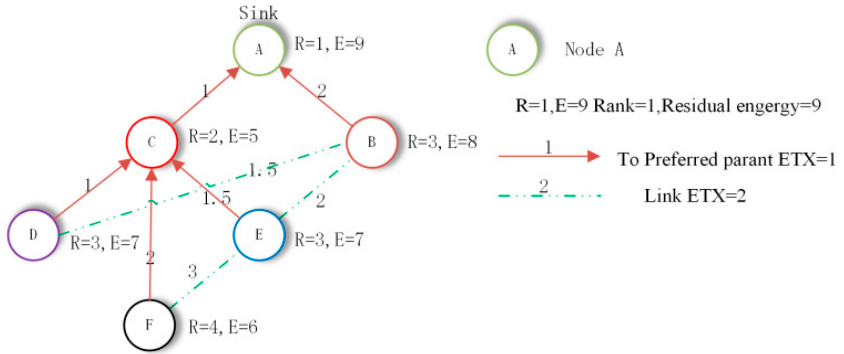
Figure 1. Topological structure based on ETX.